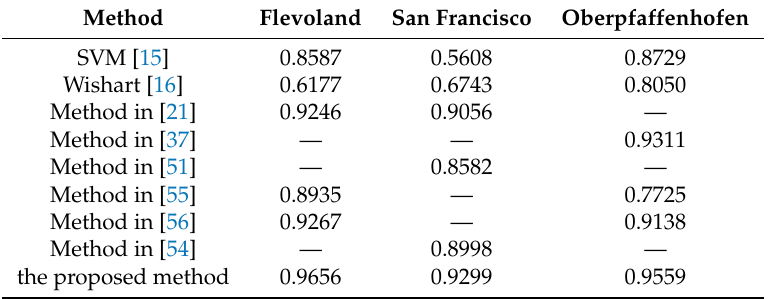
Table 4. The comparison of the proposed method with several state-of-the-art